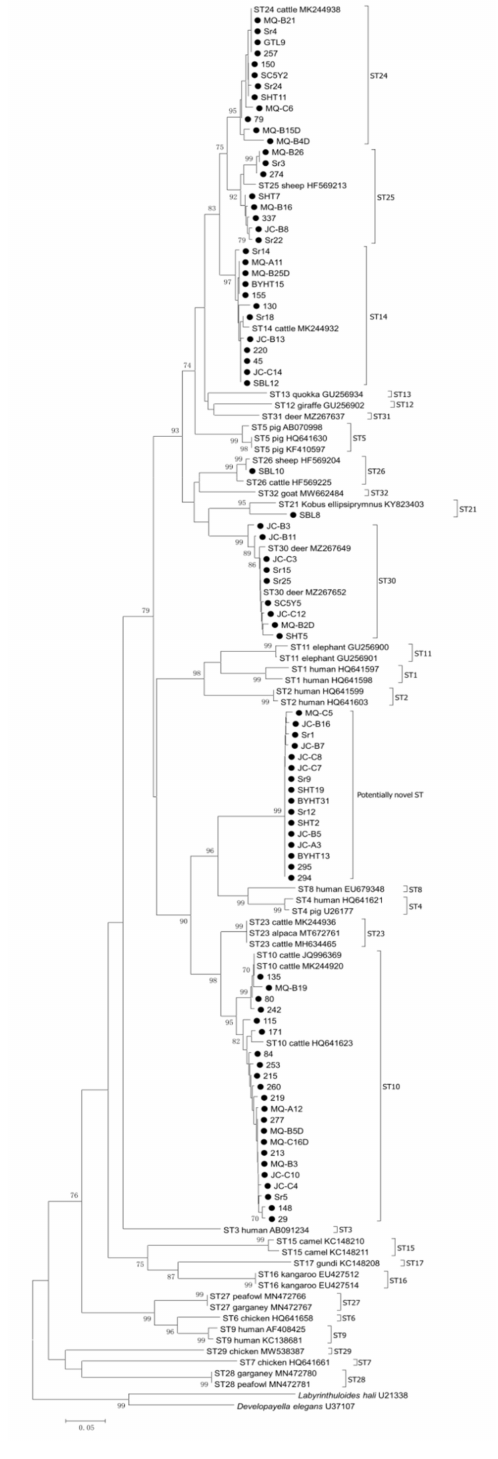
Figure 2. Phylogenetic relationships of Blastocystis subtypes in the present study (black filled circles before the sample name) with reference sequences from GenBank TM based on the sequence analysis of the SSU rRNA gene by neighbor-joining analysis using the Kimura 2-parameter model. Boot- strap values (>70) are indicated at the nodes. Scale bar indicates 0.05 nucleotide substitutions/site. Labyrinthuloides hali (U21338) and Developayella elegans (U37107) are used as the